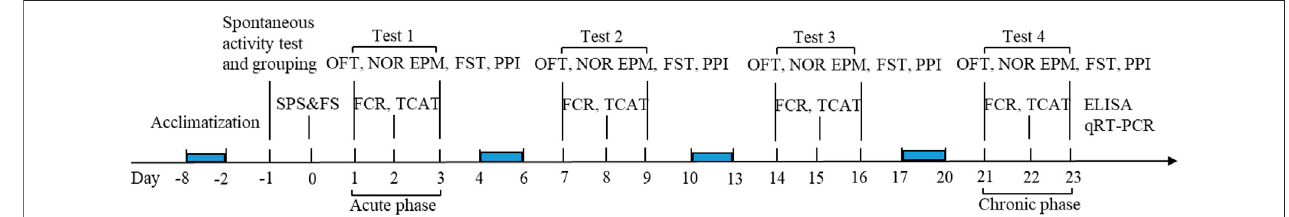
FIGURE2| Schematicrepresentationoftheexperimentalprocedure.OFT,open- fi eldtest;NOR,novelobjectrecognition;FCR,fear-conditioningresponse;TCAT, traumatic cue avoidance test; EPM, elevated plus maze test; FST, forced swimming test; PPI, prepulse